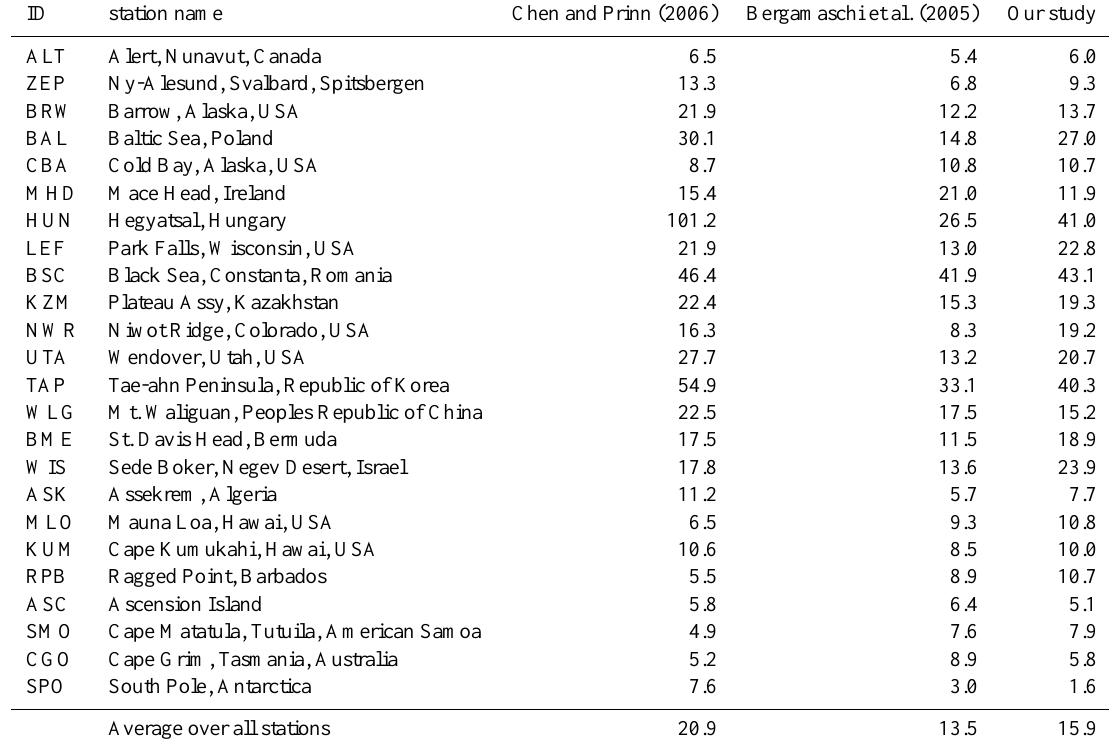
Table 4. Errors (in ppb) contained in R matrix of Chen and Prinn (2006), Bergamaschi et al. (2005) and our study at 25 surface stations.